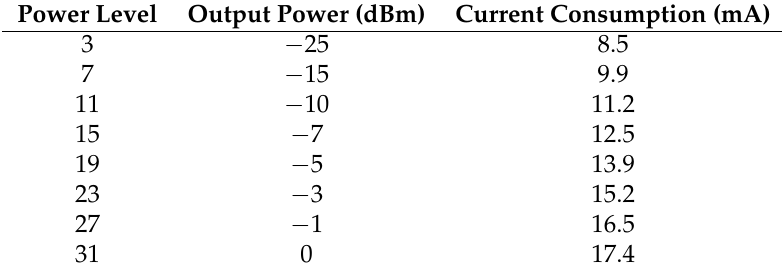
Table 1. Tmote Sky output power configuration for the CC2420 [7].